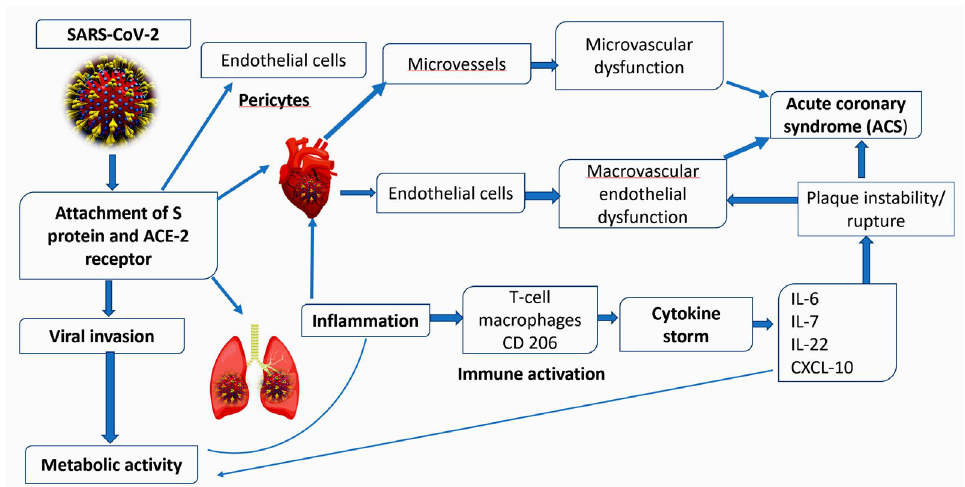
Fig. 2. Effects of SARS-CoV-2 on the heart and lungs, which result in acute coronary syndrome